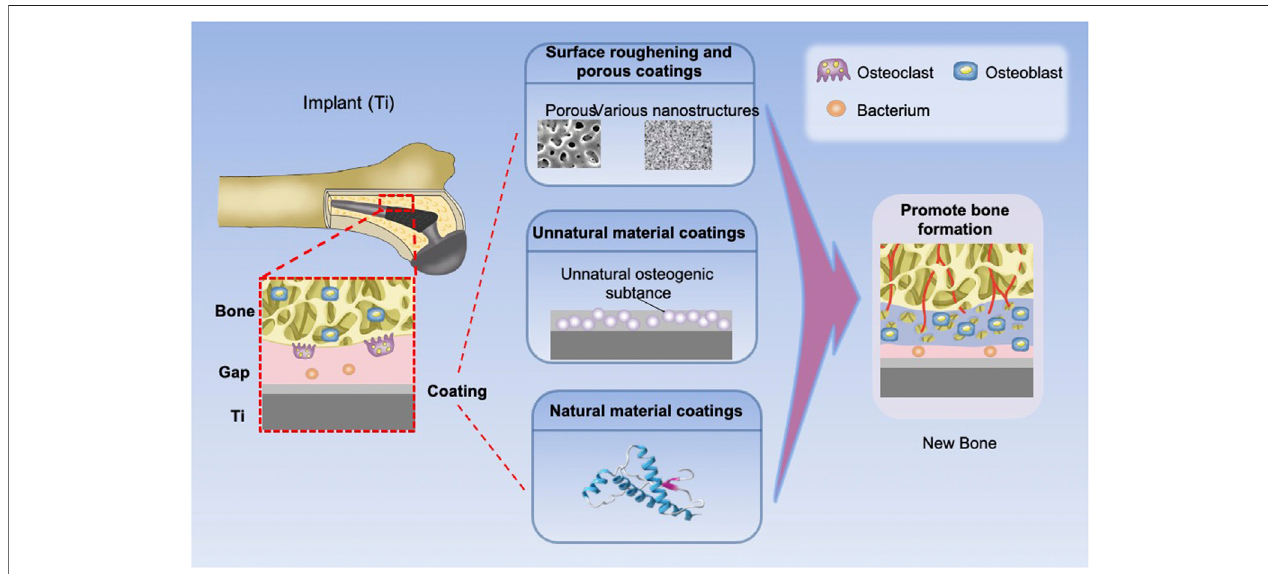
FIGURE 1 | Types and effects of osteogenic coatings on titanium implants. The elastic coating can fi ll the interface gap by expansion. The implants with surface morphology coatings, inactive coatings, and bioactive coatings can promote new bone formation.